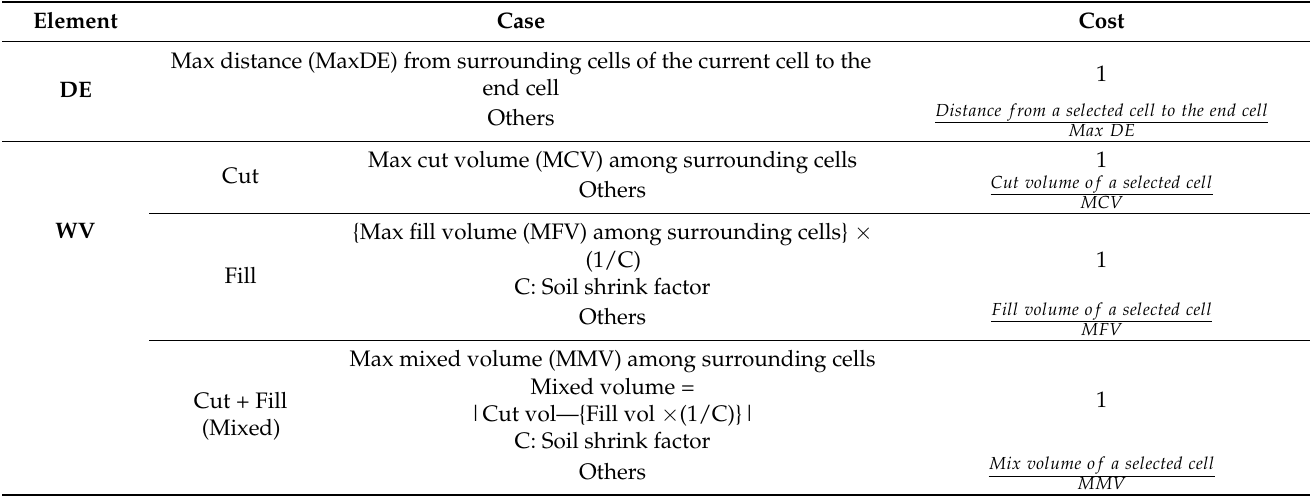
Table 3. Cost accounting by elements of the moving cost